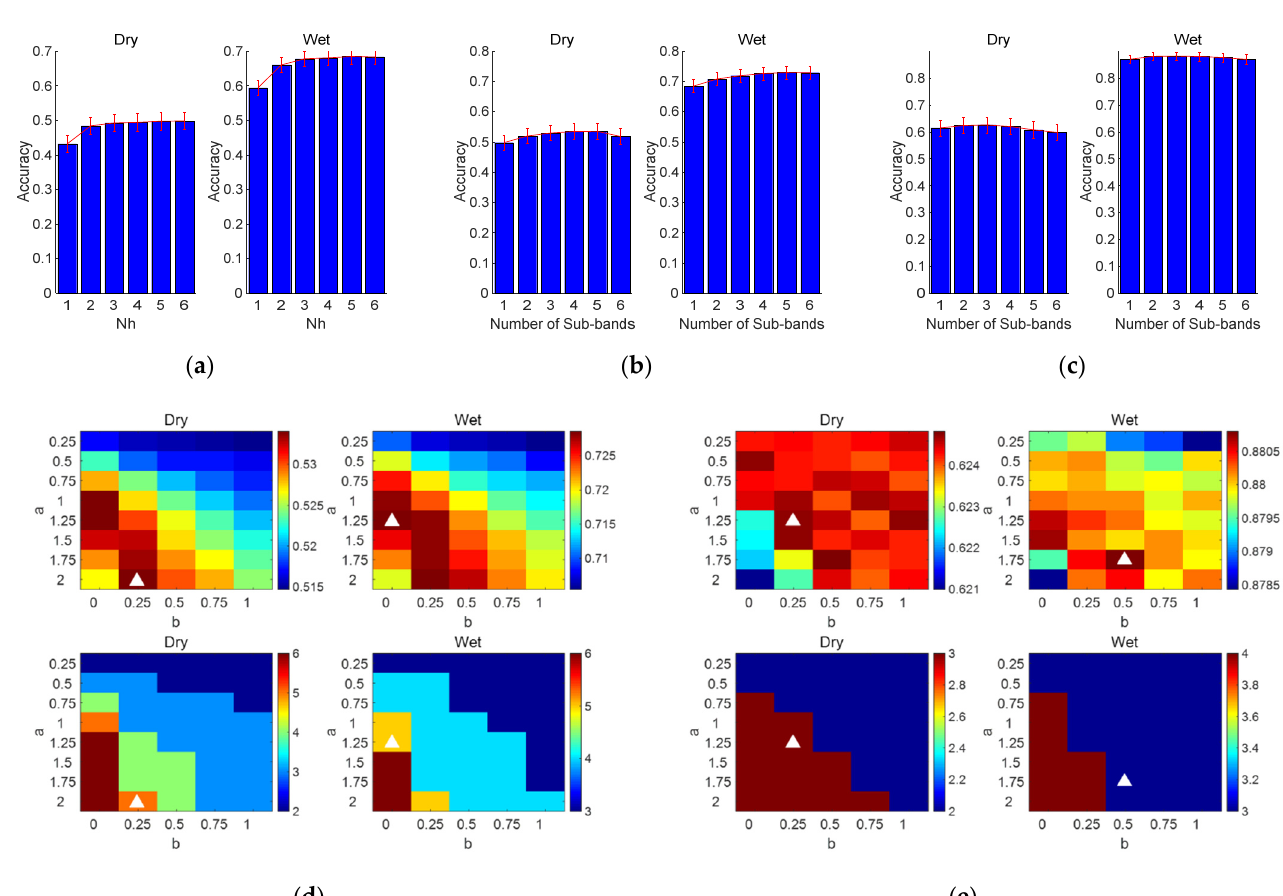
Figure 6. ( a ) In the standard CCA method, the classification accuracy of the different harmonics at 1 s data length. Classification accuracy at different N values (from 1 to 6 with a step of 1): ( b ) FBCCA, ( c ) FBTRCA. The weight vector w (i.e., a and b ) and the number of sub-bands N corresponding to the maximum classification accuracy optimized by the grid search method: ( d ) FBCCA, ( e ) FBTRCA. The error bars in ( a – c ) represent the standard errors. In ( d , e ), the color bar in the top two subgraphs represents the classification accuracy, while the color bar in the bottom two subgraphs corresponds to the number of sub-bands N.